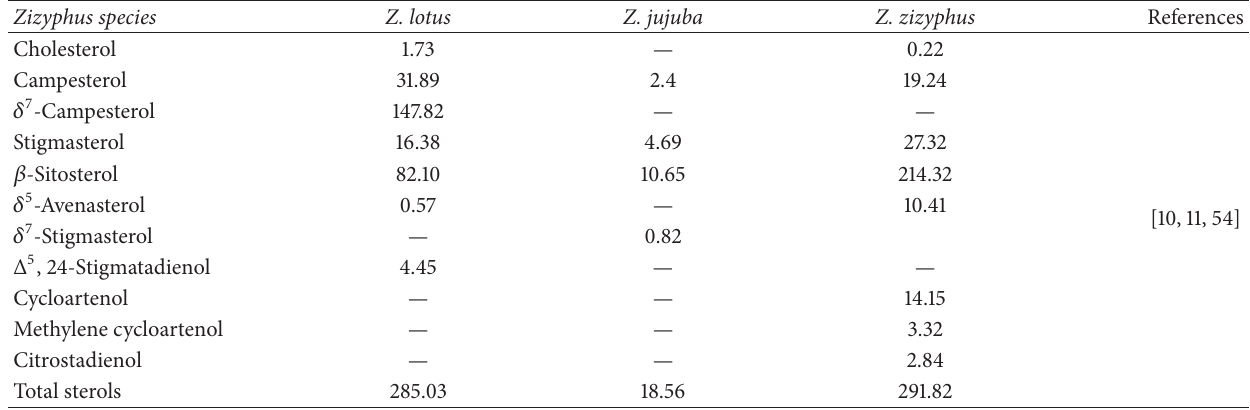
Table 5: Comparison of sterols composition of Z. lotus seed oil and other edible oils. Sterol contents are expressed in mg/100 g. Zizyphus species